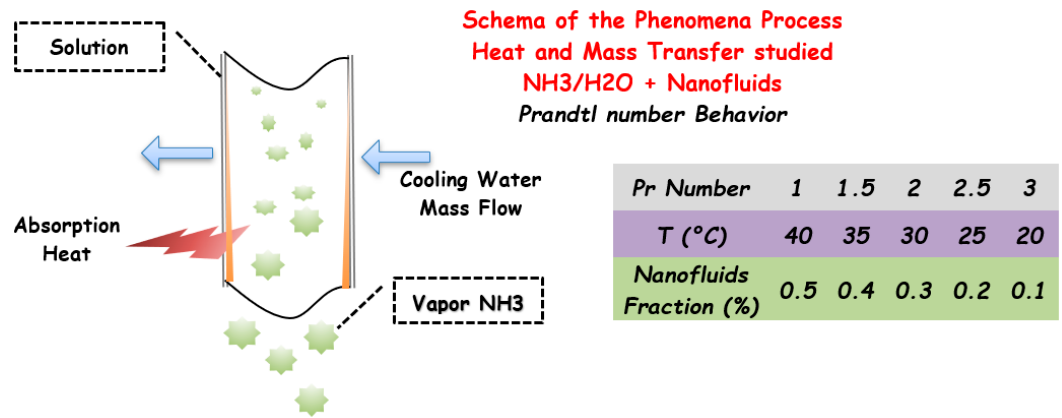
Figure 10. Absorption process in a falling film tube. Effective coefficient of Prandtl number ratio behavior at different concentrations of nanofluids at different temperatures.